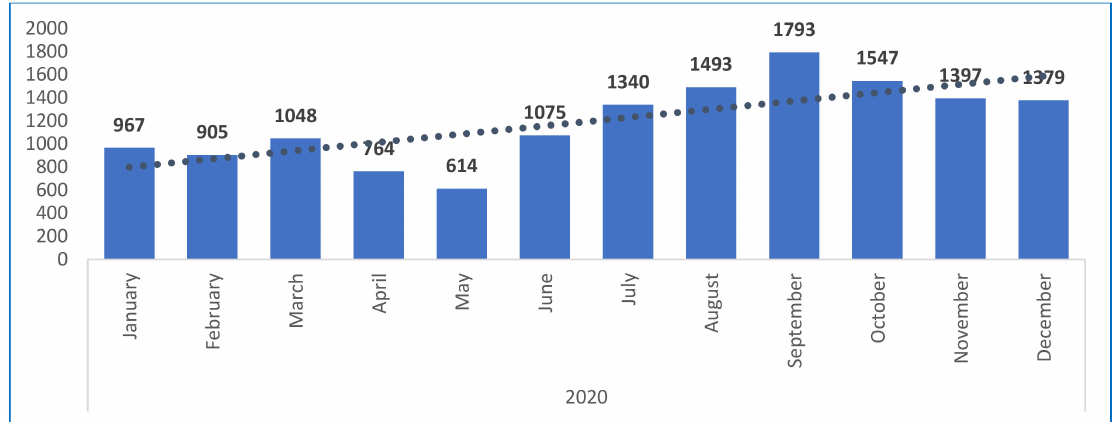
Figure 6. Number of under five children admitted to TFCs in 2020, by month. Abbreviations: TFCs: therapeutic feeding